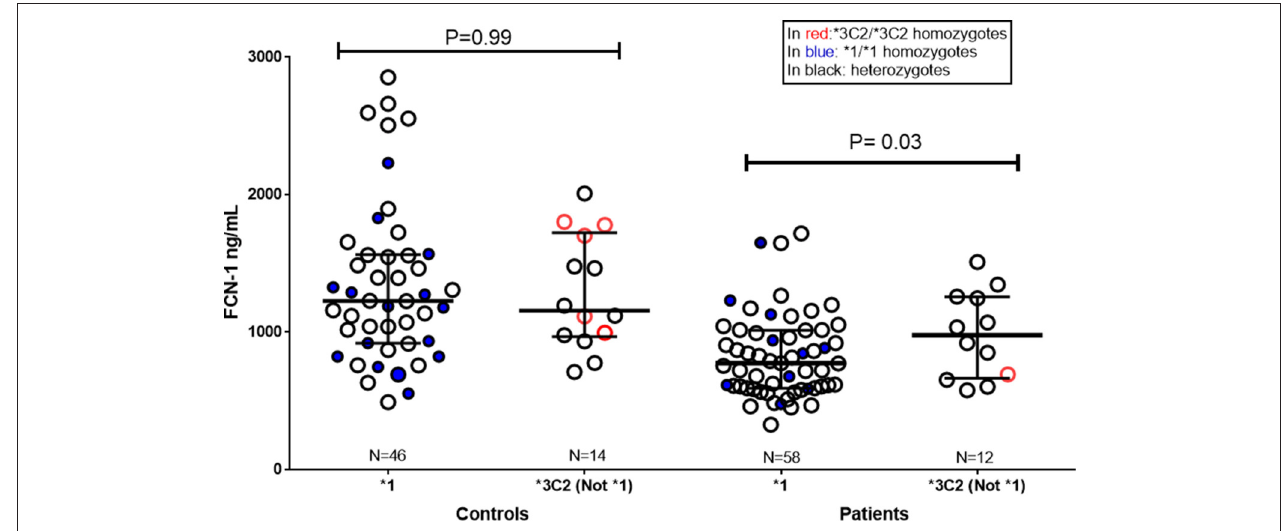
FIGURE 3 | Ficolin-1 serum levels in controls and RF patients, according to FCN1 genotype. *1: carriers of the * 1 “risk” haplotype ( GGGCG ). Not * 1/ * 3C2 : carriers of * 3C2 “protective” haplotype ( AAGAT ), but not of the * 1 “risk” haplotype. In red: * 3C2/ * 3C2 homozygotes. In blue: * 1/ * 1 homozygotes. Subjects carrying the other FCN1 haplotypes are not represented in the figure (Controls N = 26, Patients N = 8).